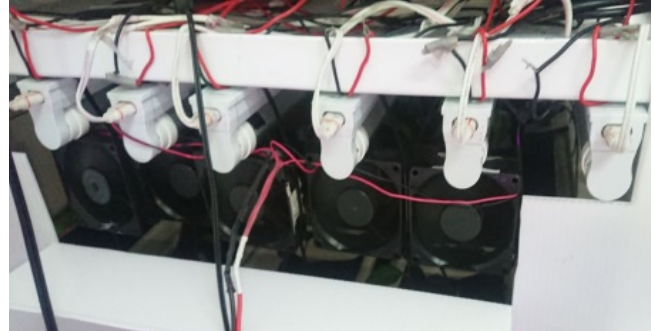
Figure 4. LED strips (top) and circulation fan (bottom).